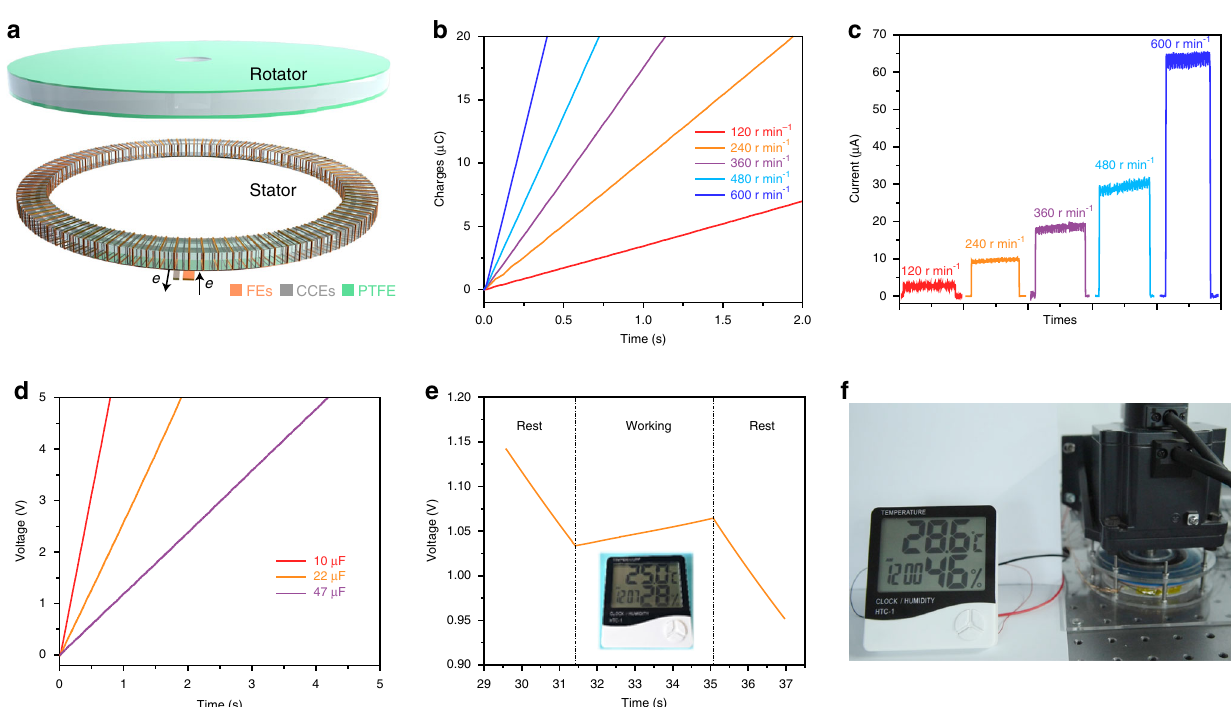
Fig. 5 Application of MDC-TENG to drive electronic device. a Structural schematic of rotary MDC-TENG device. b Output charges and c I sc of rotary MDC-TENG at various rotation rates. d Charging curves of 10, 22, and 47 µ F commercial capacitors charged by rotary MDC-TENG at 600 r min − 1 . e Charging curve of the 660 µ F commercial capacitor with driving thermo-hygrometer simultaneously by rotary MDC-TENG at 600 r min − 1 . f Photograph of driving thermo-hygrometer directly by rotary MDC-TENG at 600r min − 1 continuous DC output, a rotary mode MDC-TENG was pre- pared. Its schematic diagram (stator: MDC-TENG) is shown in Fig. 5a. PTFE fi lm is attached on the rotator surface. The stator is a rotary type MDC-TENG device, whose structure is similar to the sliding mode MDC-TENG (Fig. 1a) with interlaced CCEs and FEs. Figure 5b shows the output charges of the rotary MDC- TENG at different rotation rates. With the rotation rate rising, output charge reaches to 20 µC within a short time. For example, it only takes 0.3 s to output 20 µC charges at the rotation rate of 600 r min − 1 . When the rotary MDC-TENG works stably, the output current is about 65 µA at 600 r min − 1 (Fig. 5c), accom- panied with a typical DC curve (the crest factor is close to 1). Three commercial LED bulbs (each rated power: 7 W) can also be directly driven with high brightness and no fl ash due to the high DC output (Supplementary Movie 1).